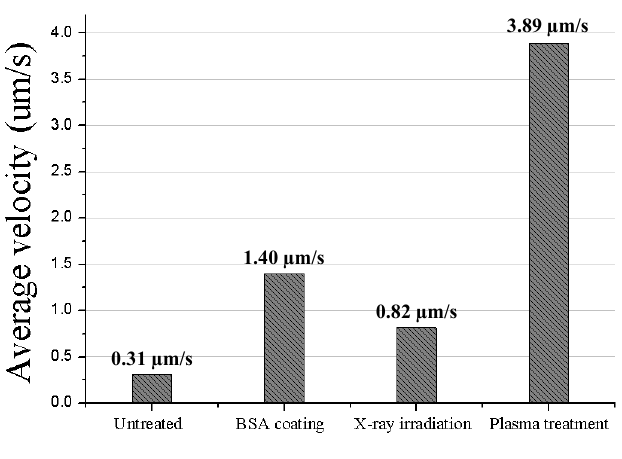
Figure 6. Average velocities of